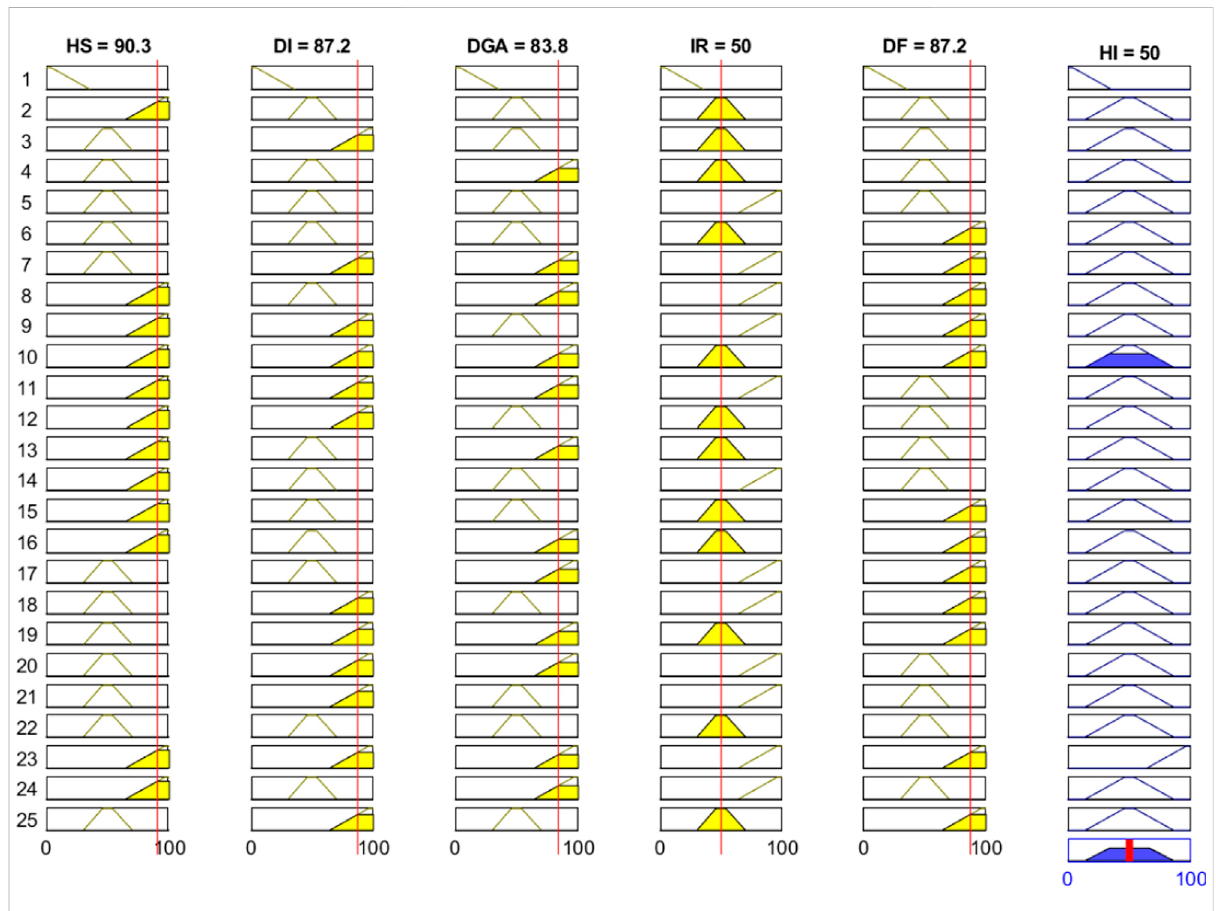
FIGURE 16 Rules used in fuzzy sublogic for